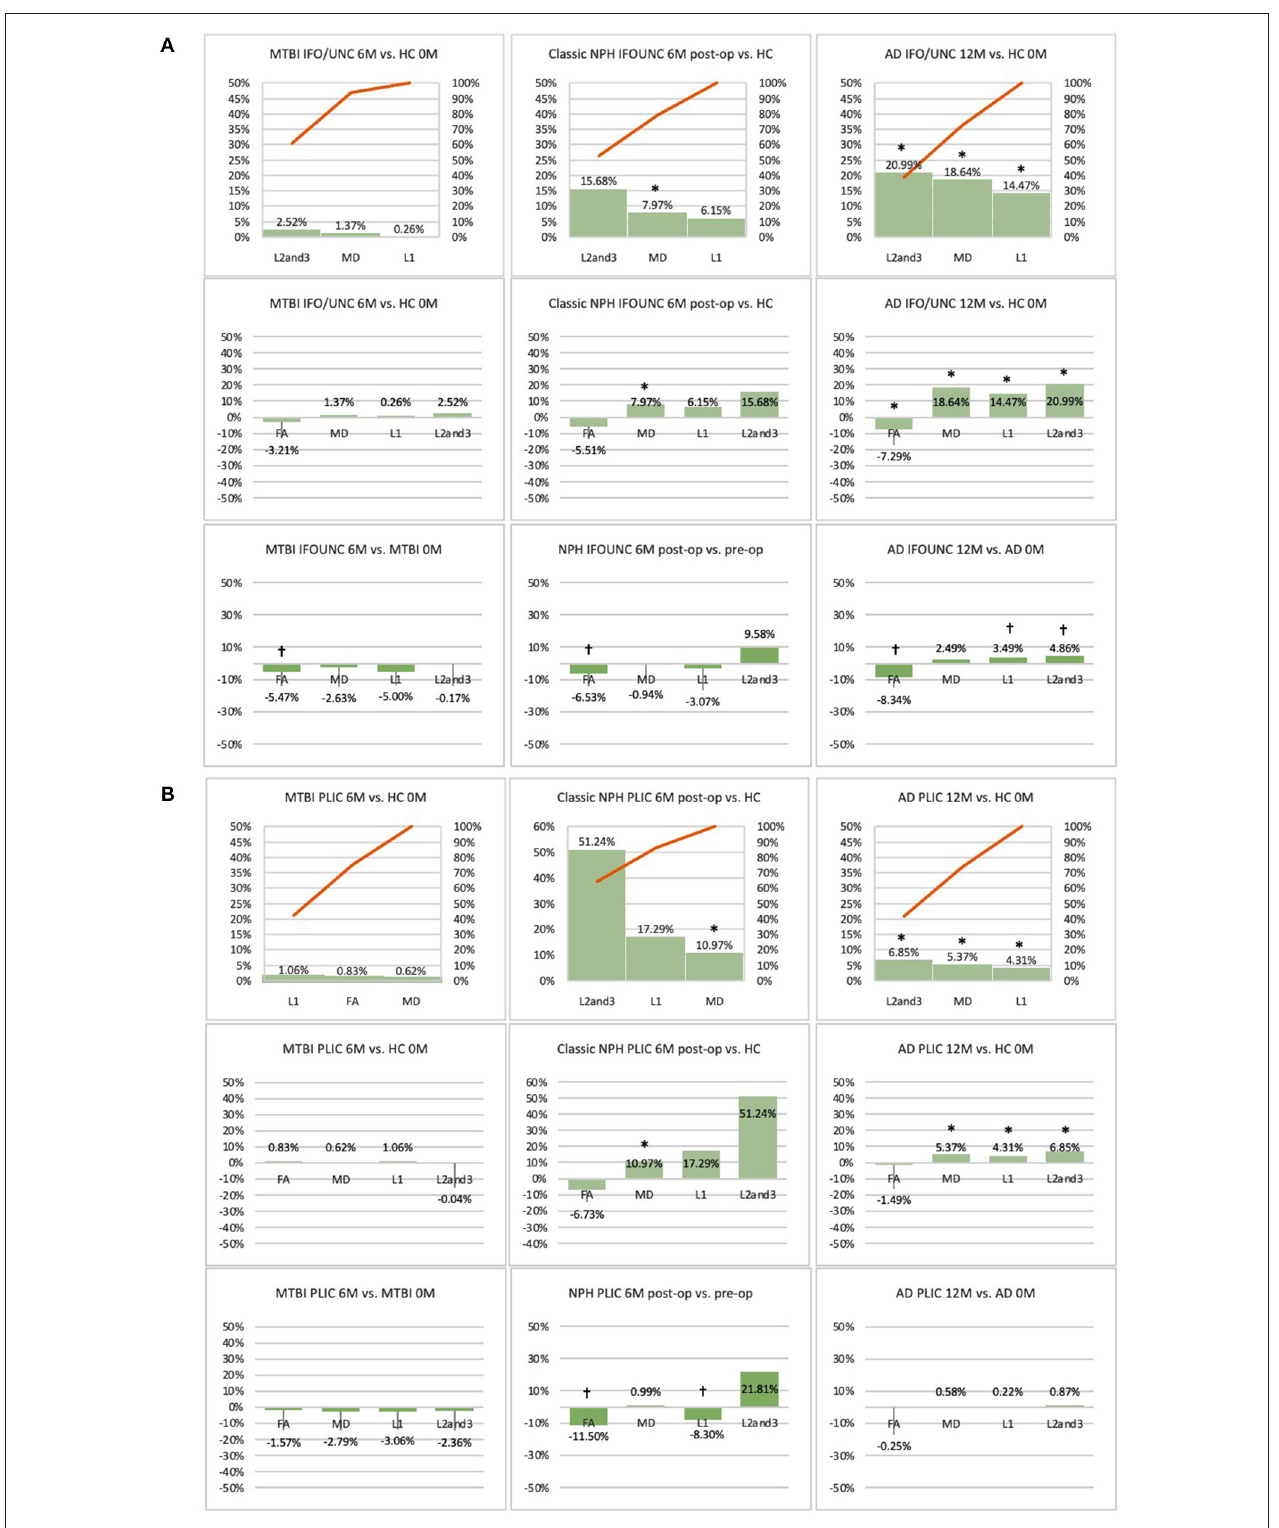
FIGURE 6 | (A) Fronto-temporal (IFO/UNC) and (B) remote functional (PLIC) ROI families at follow-up. At 6 or 12-month follow-up, percentage changes in DTI measures of clinical cohorts are compared against corresponding healthy controls at baseline, presented as Pareto graphs and bar charts. At this time point, patients are also compared to themselves at baseline, presented as bar charts. We observed that, in MTBI, the IFO/UNC combination ROI at 6-month follow-up demonstrated a pattern of distortion/oedema (predominant increase in radial diffusivity with a significant decrease in FA), whereas in NPH, we found changes consistent